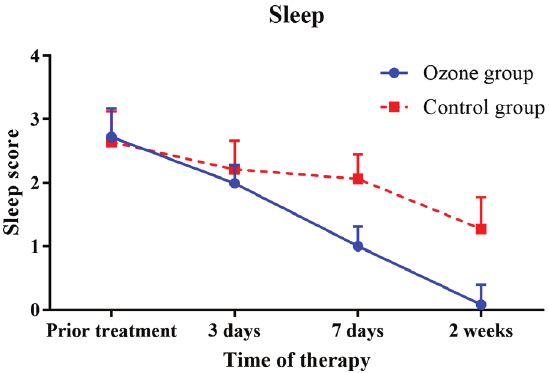
Figure 4. Sleep score profiles of the two groups at different times.